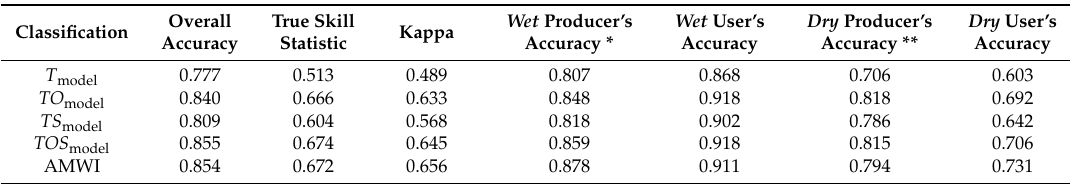
Table 3. Model and Alberta Merged Wetland Inventory (AMWI) classification accuracy measures, including class producer’s and user’s